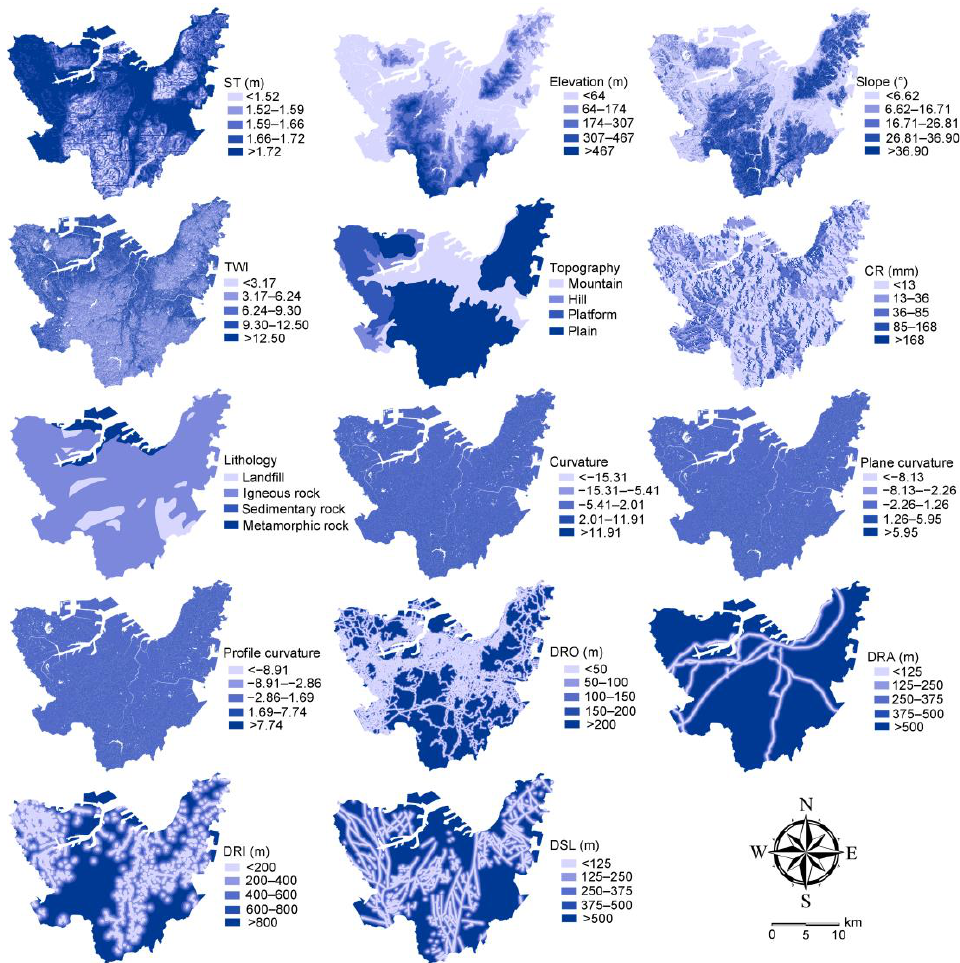
Figure 4. Maps of landslide influencing factors, namely soil thickness, elevation, slope, topographic wetness index (TWI), topography, cumulative runoff, lithology, curvature, plane curvature, profile curvature, distance to the road (DRO), distance to the railway (DRA), distance to a river (DRI) and distance to a structure line (DSL).